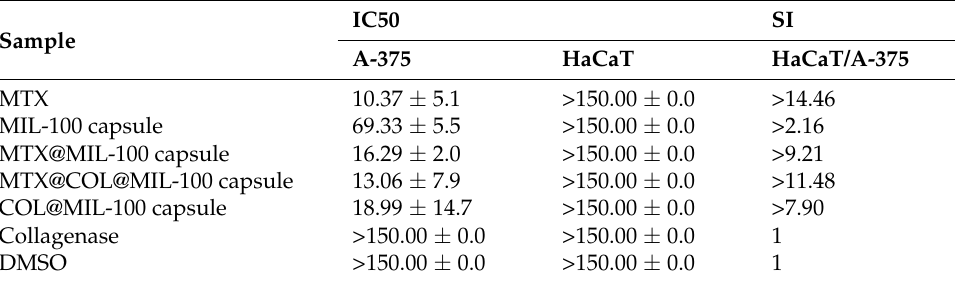
Table 1. Results of the IC 50 ( µ g/mL) and selectivity index